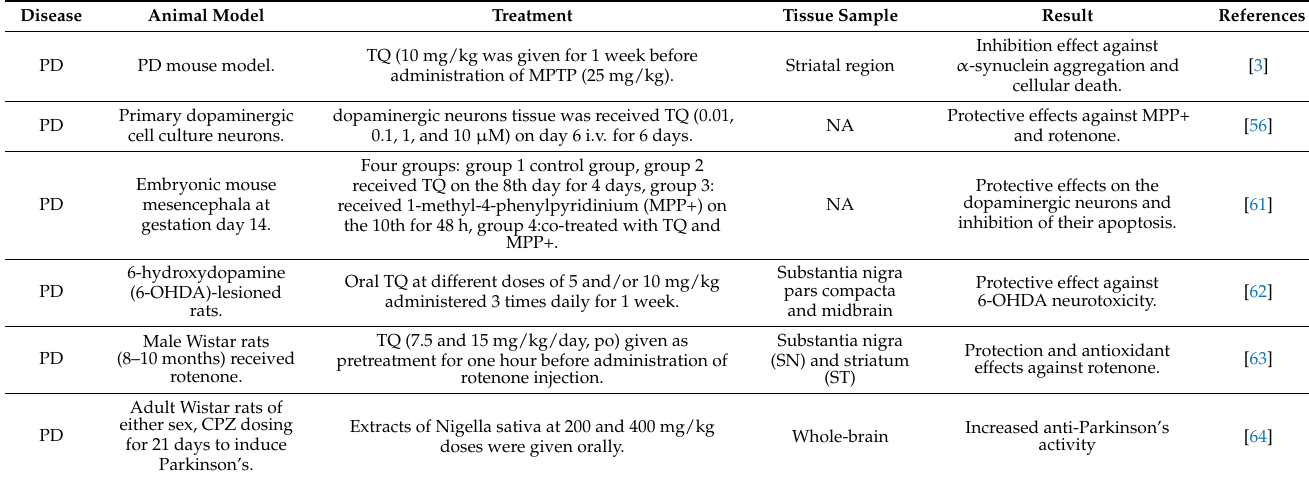
Table 2. Animal studies on the effect of Thymoquinone on